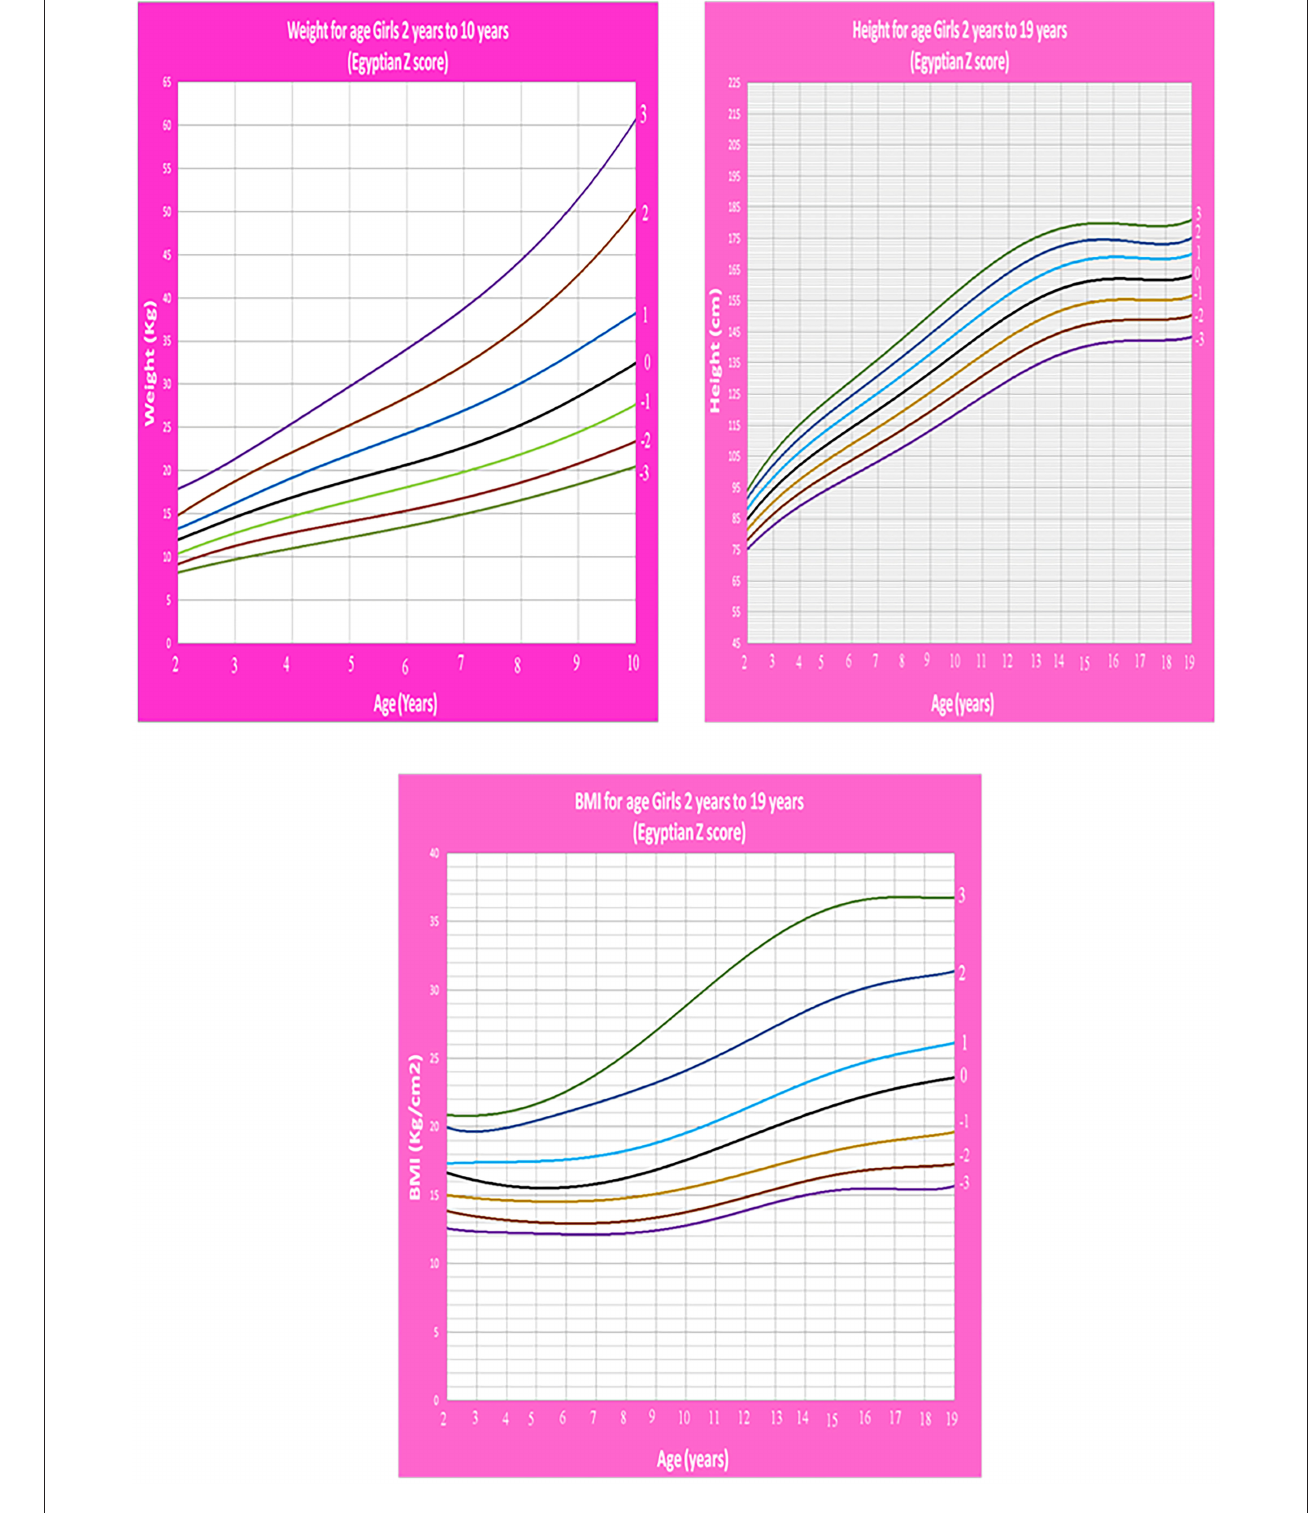
FIGURE 11 | Egyptian Z score weight-, height-, BMI- for age from 2 to 19 years for girls.